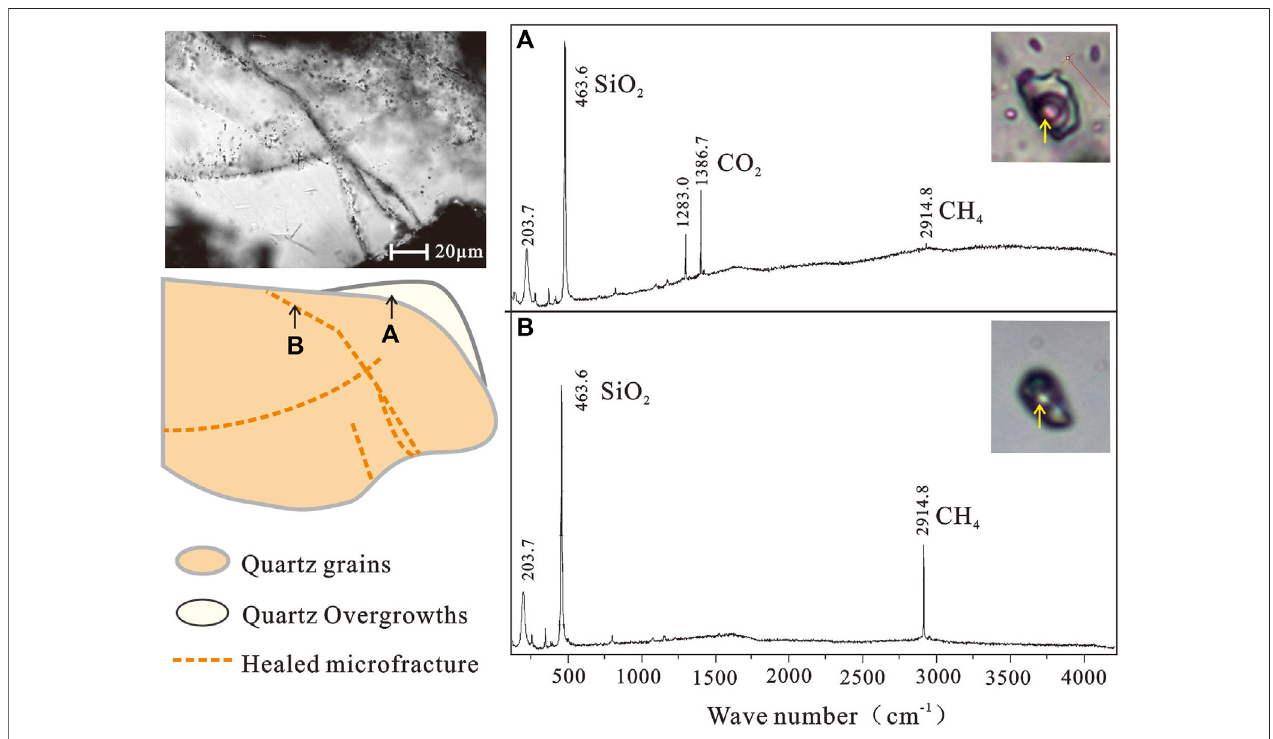
FIGURE 2 | Raman spectrogram of gaseous hydrocarbon inclusions (Mi-6, 2,638.4 m).